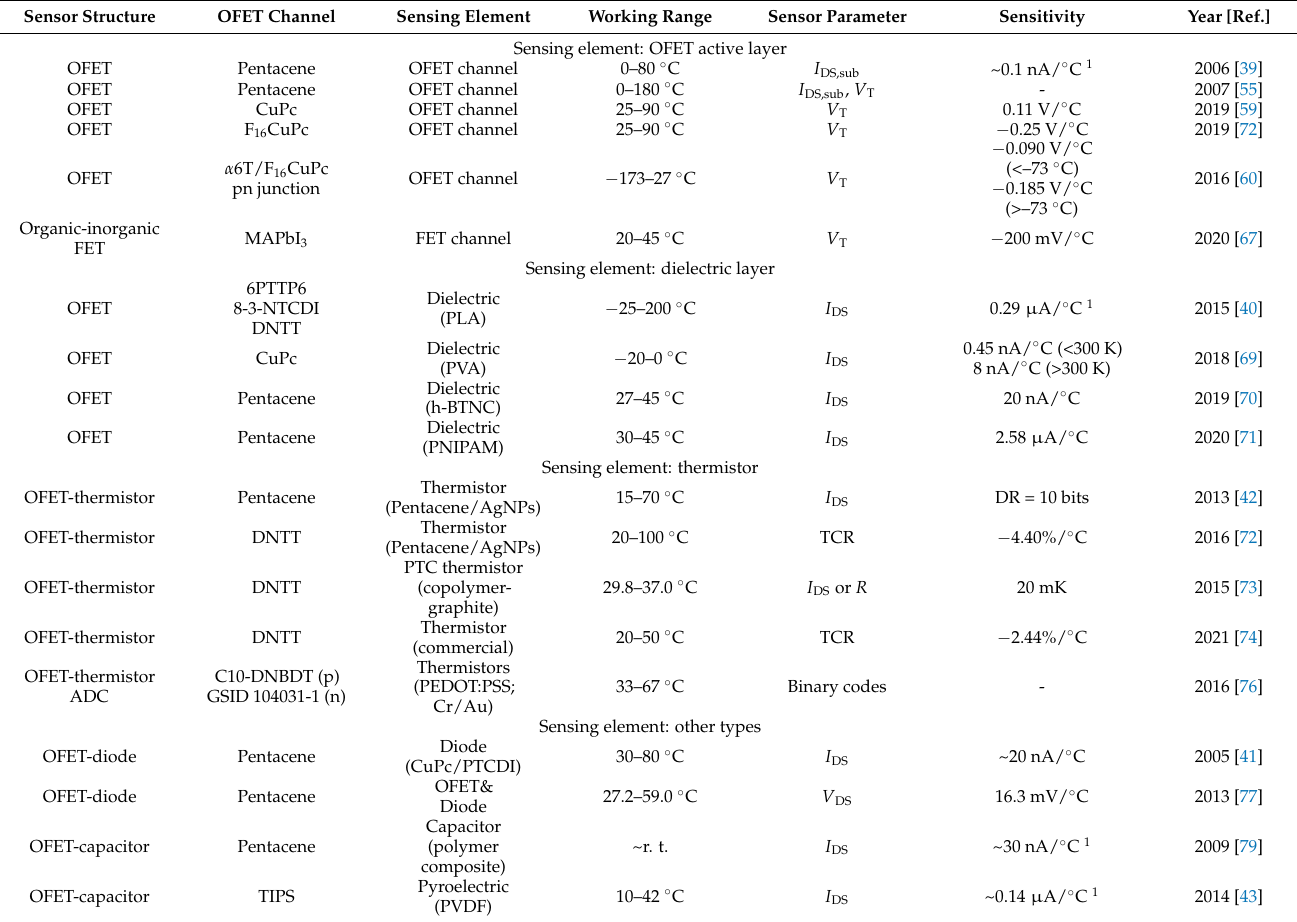
Table 1. Summary of of small-molecule OFET temperature